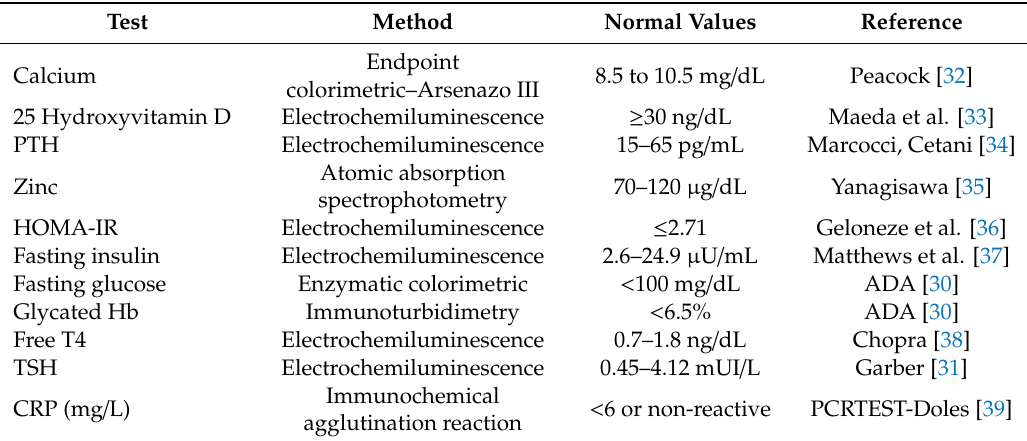
Table 1. Biochemical tests, methods and reference